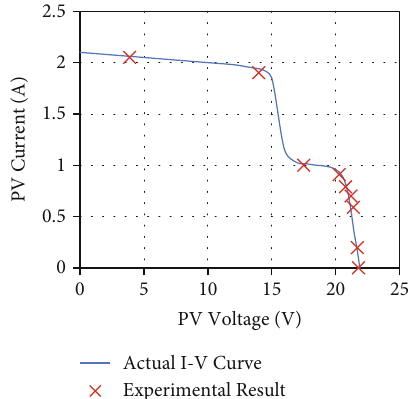
Figure 17: I-V characteristics obtained from the